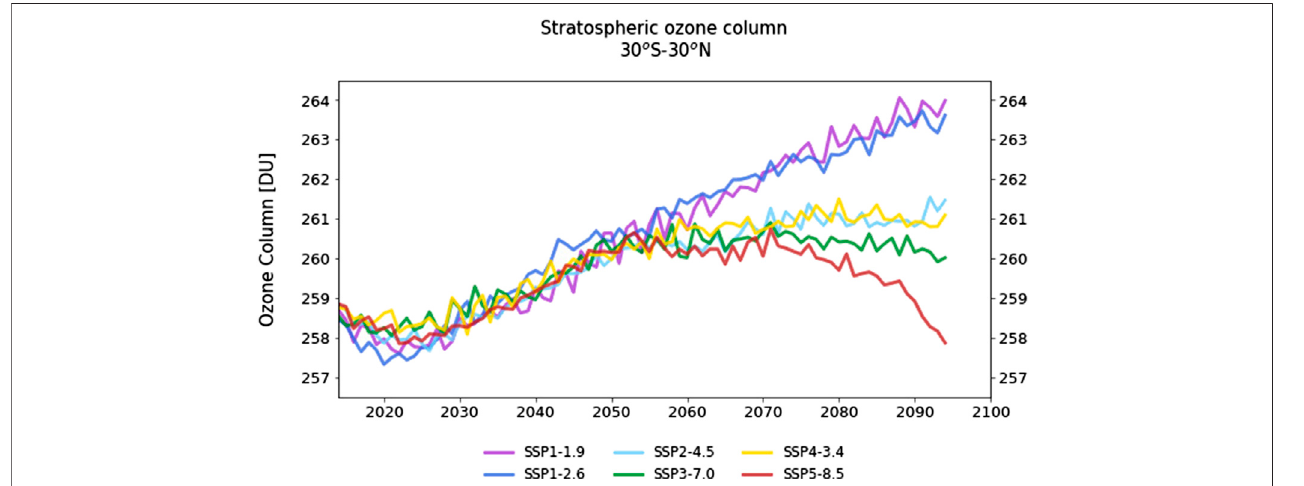
FIGURE 2 | UKESM1 projections of stratospheric column ozone under different Shared Socioeconomic Pathways, averaged over 30 ° S – 30 ° N. Projections shown here have been smoothed using an 11-point boxcar smoothing applied to the annual mean stratospheric column ozone values.